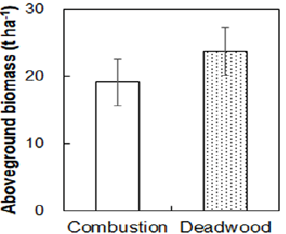
Figure 3. Differences in total aboveground biomass ( A , total; B , tree layer; C , shrub layer; D , herbaceous layer; E , litter) between the unburned and burned plots. Different letters indicate significant differences between treatments at p < 0.05. Values are presented as the means ± standard error.